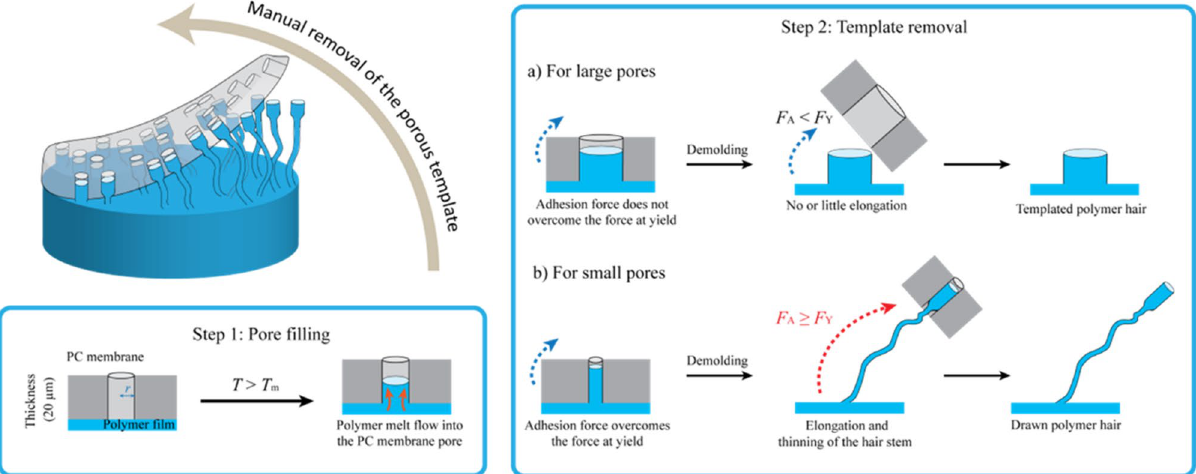
Figure 1. Pore-assisted modifications of polymer film surfaces using ion-track etched PC membranes as porous templates. Depending on the pore size either ( a ) microreplicated cylinders or ( b ) drawn hair-like nano- and microstructures can be